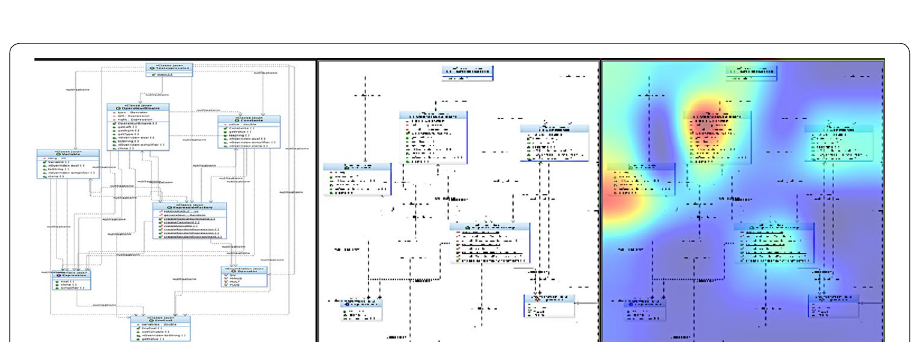
Fig. 4 Class activation mapping prediction for a selected UML class diagram, original image on the left, resized image in the middle, heatmap indicating significant features on the right